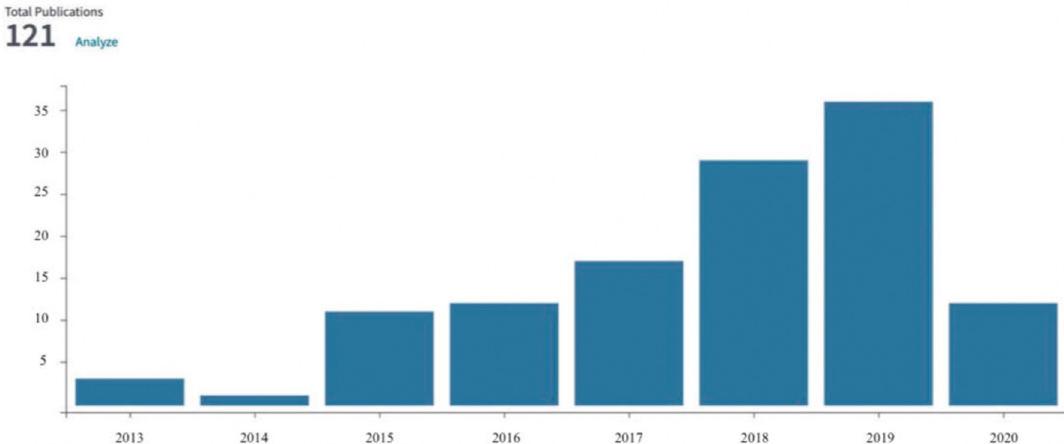
Figure 1. The number of papers found in the Web of Science database.